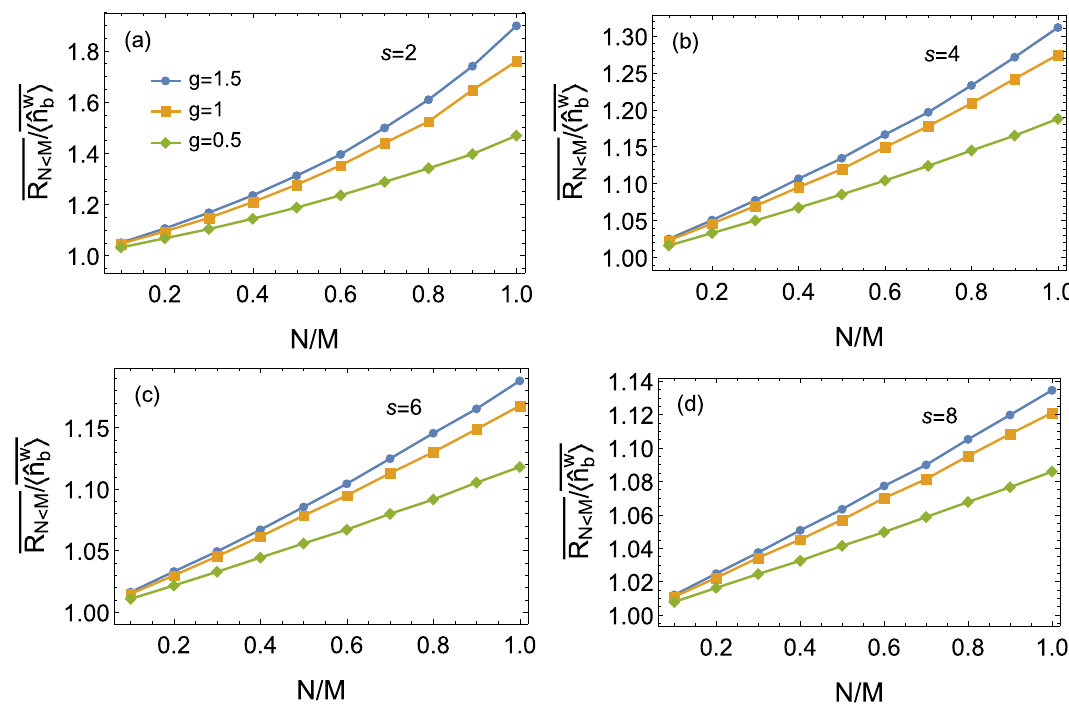
n w b � as a function �ˆ 2 10000, M 50 α n w b � . Parameters: | �ˆ | = =